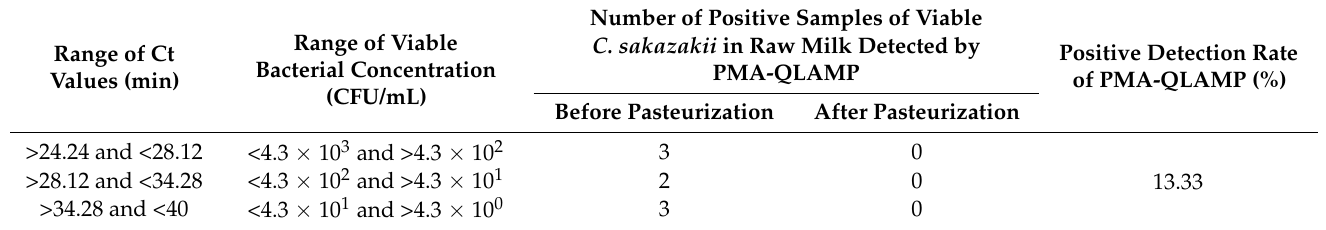
Table 4. PMA-QLAMP test results of viable C. sakazakii in raw milk before and after